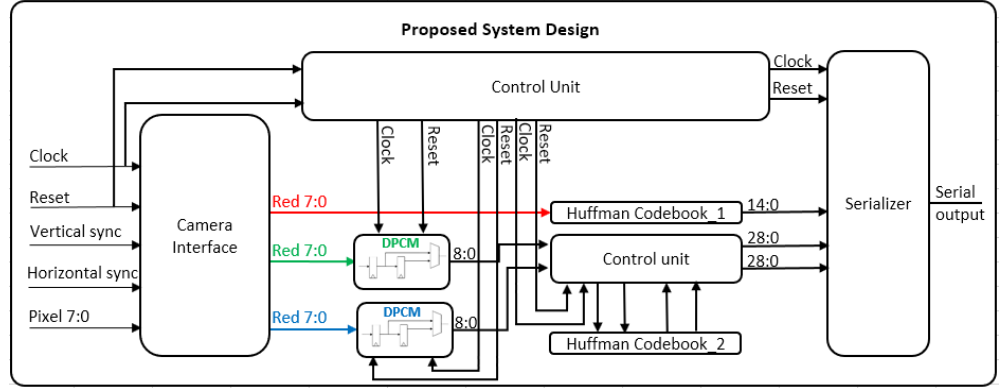
Figure 7. Multiplier-less hardware implementation block diagram.